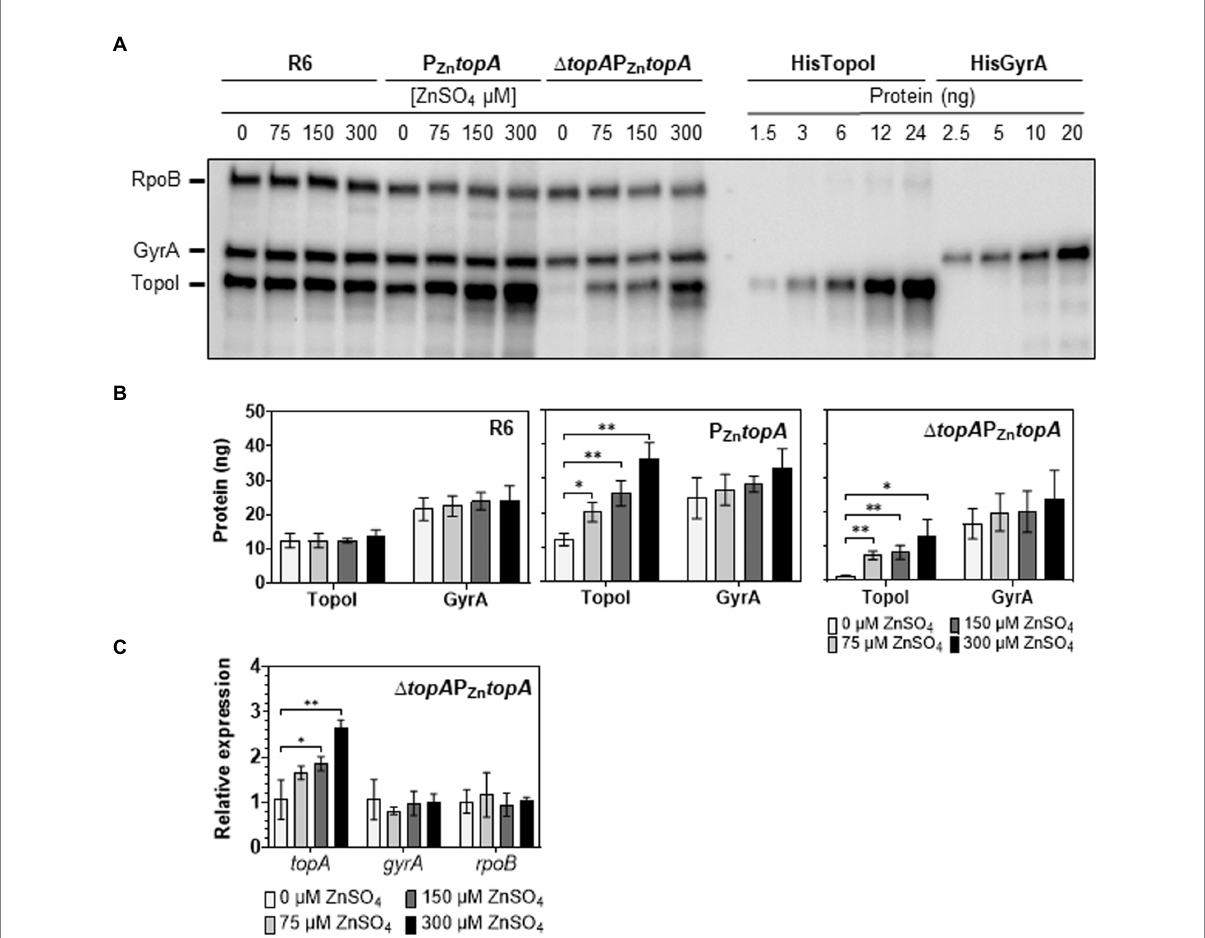
FIGURE 2 Levels of TopoI in strains carrying P Zn topA fusions correlate with the concentration of ZnSO 4 in the growth media. (A) A typical Western-blot of TopoI and GyrA is shown. Cells were grown overnight to OD 620nm = 0.4 (as measured in the spectrophotometer) in medium containing 75 μ M ZnSO 4 . They were diluted 100-fold in media containing the indicated ZnSO 4 concentrations and regrown to OD 620nm = 0.4, except for Δ topA P Zn topA grown without ZnSO 4 and P Zn topA grown with 300 μ M ZnSO 4 , which samples were taken after 240 min. Samples containing 0.12 units of OD 620nm (about 20 μ g) were separated by SDS-PAGE and blotted. The membrane was incubated with polyclonal anti-GyrA, anti-TopoI, and anti-RpoB antibodies. The indicated amounts of purified TopoI and GyrA proteins were also analyzed (last nine lines) to use as reference to quantify the amount of these proteins in the crude extracts. (B) Quantification of Western-blot experiments. The results (mean ± SD) of three independent replicates are presented. (C) Relative expression of topA and gyrA in Δ topA P Zn topA strain measured by qRT-PCR. Results are the mean ± SD of three